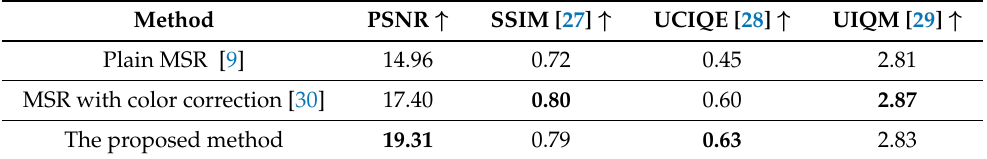
Table 2. Quantitative comparison of two MSR-based methods and the proposed method. The best results in terms of each metric are shown in bold. The UIEB test dataset was used for